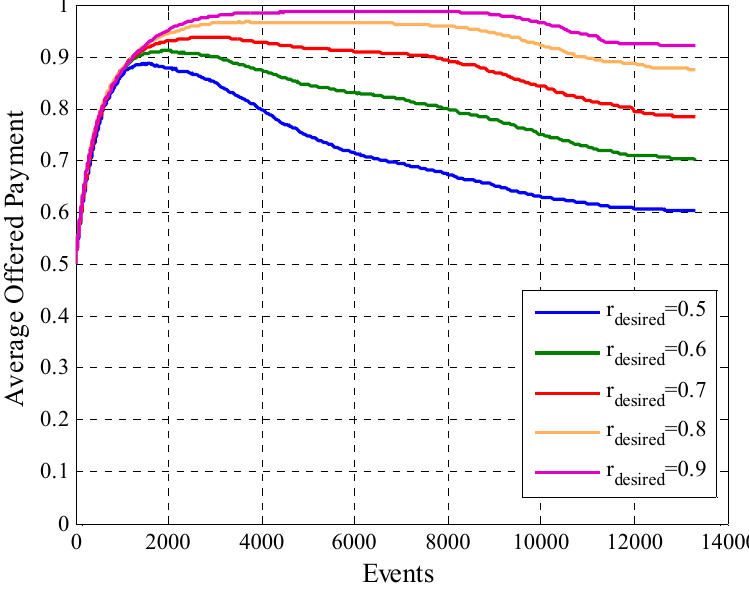
Figure 23. Cooperation rate for configurations with different values of 𝑟 (cid:3031)(cid:3032)(cid:3046)(cid:3036)(cid:3045)(cid:3032)(cid:3031) .